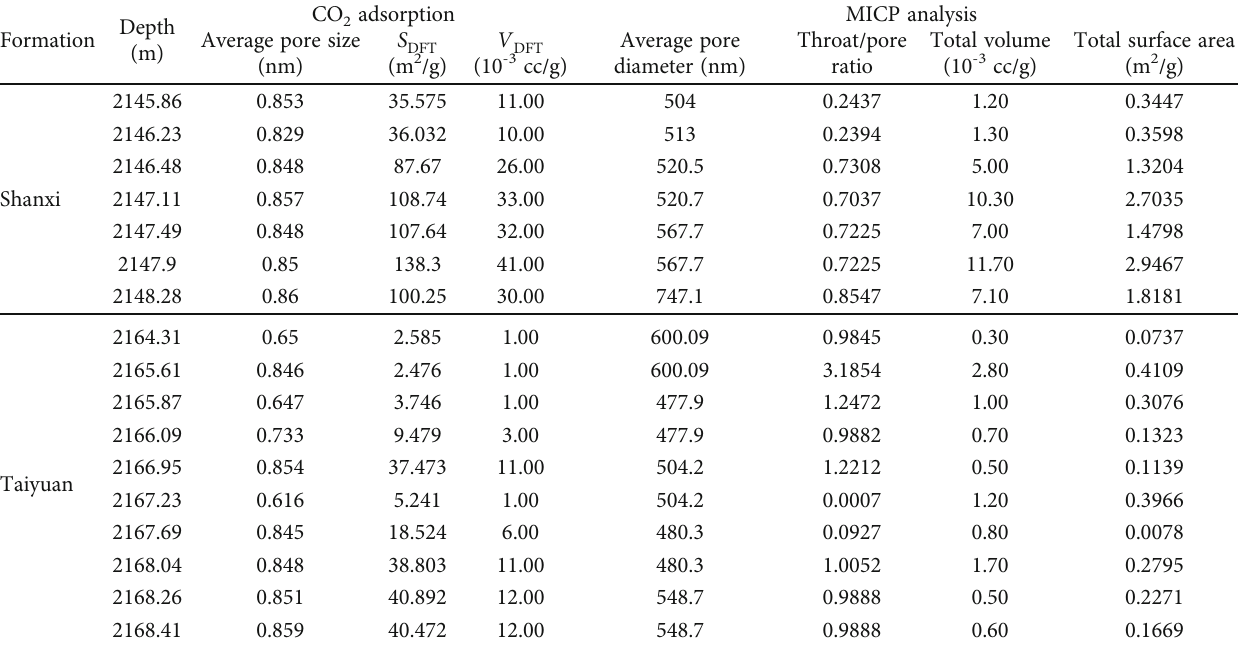
Table 2: Average pore size, pore volume, and pore surface area of the micropores in the SF and TF by CO pore diameter, throat/pore ratio, total pore volume, and total pore surface area of the meso-macropores in the Shanxi Formation and Taiyuan Formation by MICP analysis. Depth Formation